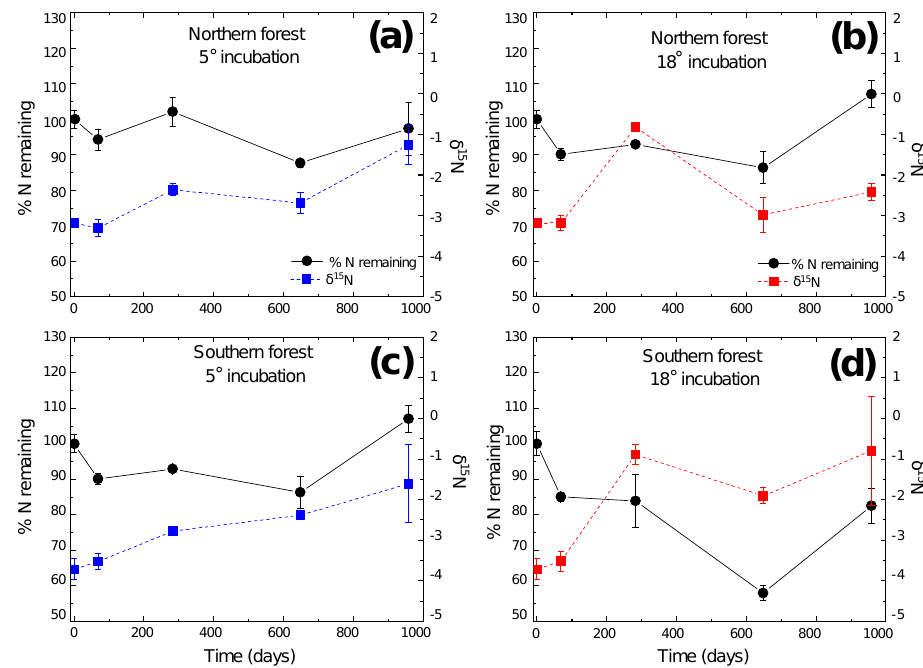
Figure 2. Percentage of initial nitrogen remaining (circles and solid lines) and δ 15 N (squares and dashed lines) at each time point. Points indicate the mean ( n = 3), with standard error depicted by error bars. Values in blue ( a and c ) are results from the 5 ◦ C incubation, and those in red ( b and d ) are from the 18 ◦ C